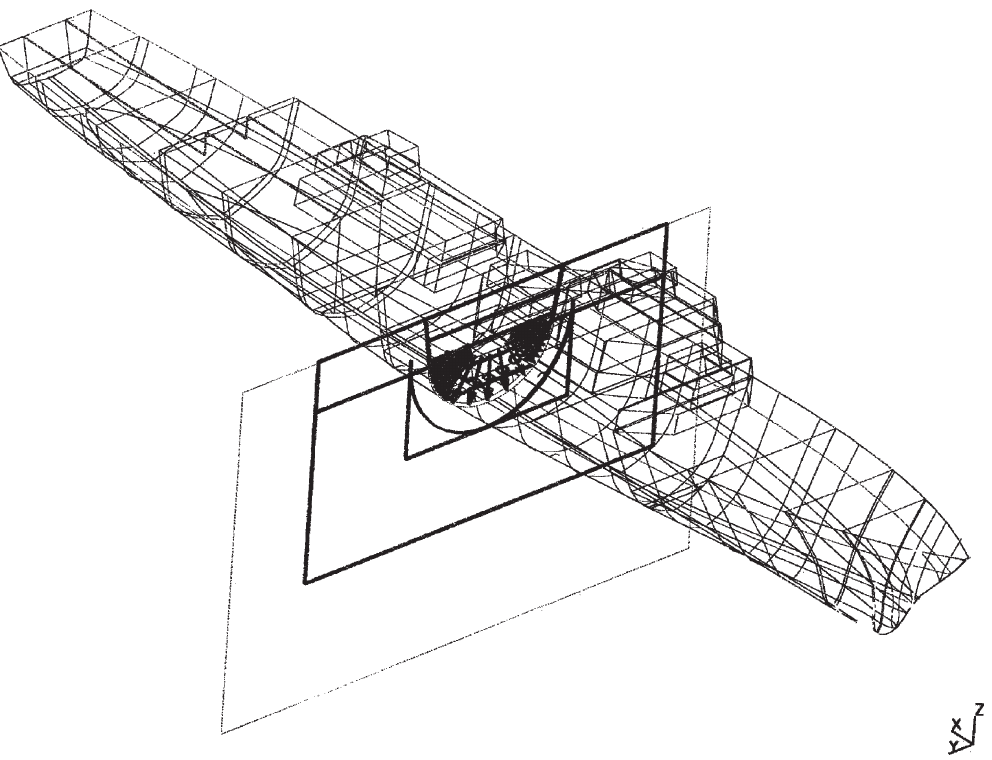
Fig. 6. Two-dimenstional mid-section of U.S. Navy’s Arleigh Burke Destroyer class ship (DDG-51 Flight